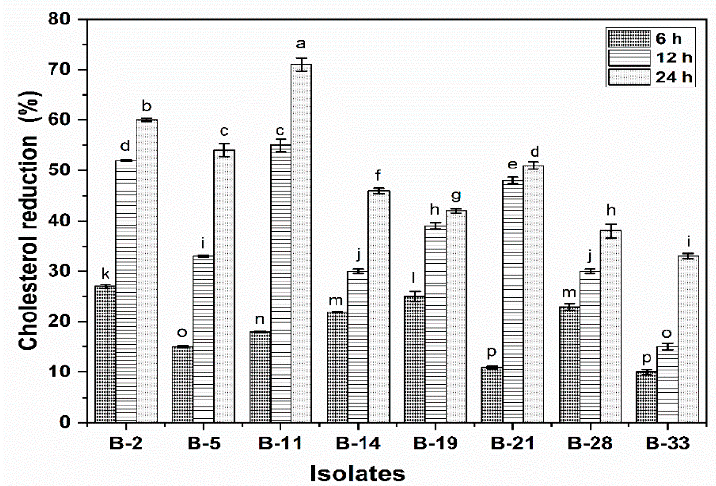
Figure 4. Cholesterol reduction (%) of isolates after 6 h, 12 h and 24 h of incubation. Each value represents the mean value ± standard deviation (SD) ( n = 3). Bars with different lower-case letters denoted significantly different ( p < 0.05).